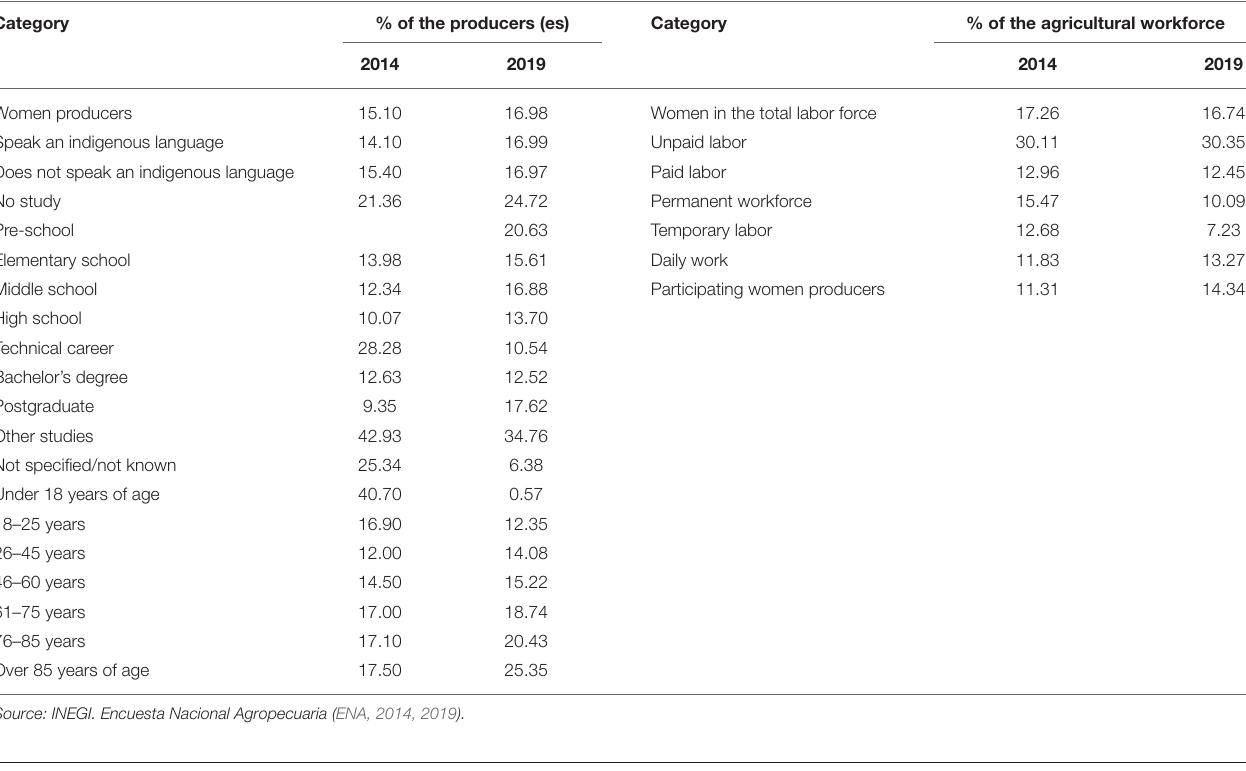
daily prayer meetings were relevant for the community